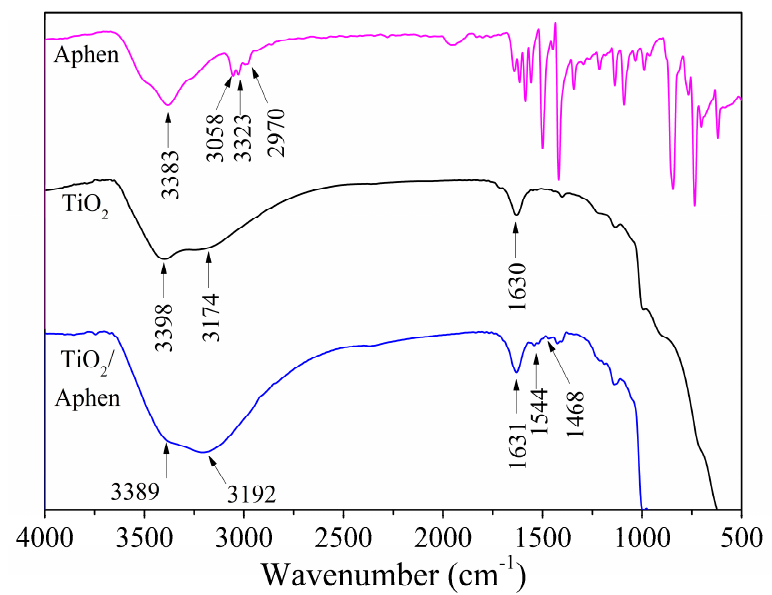
Figure 3. FTIR spectra of Aphen, TiO 2 , and TiO 2 /Aphen (1:200).